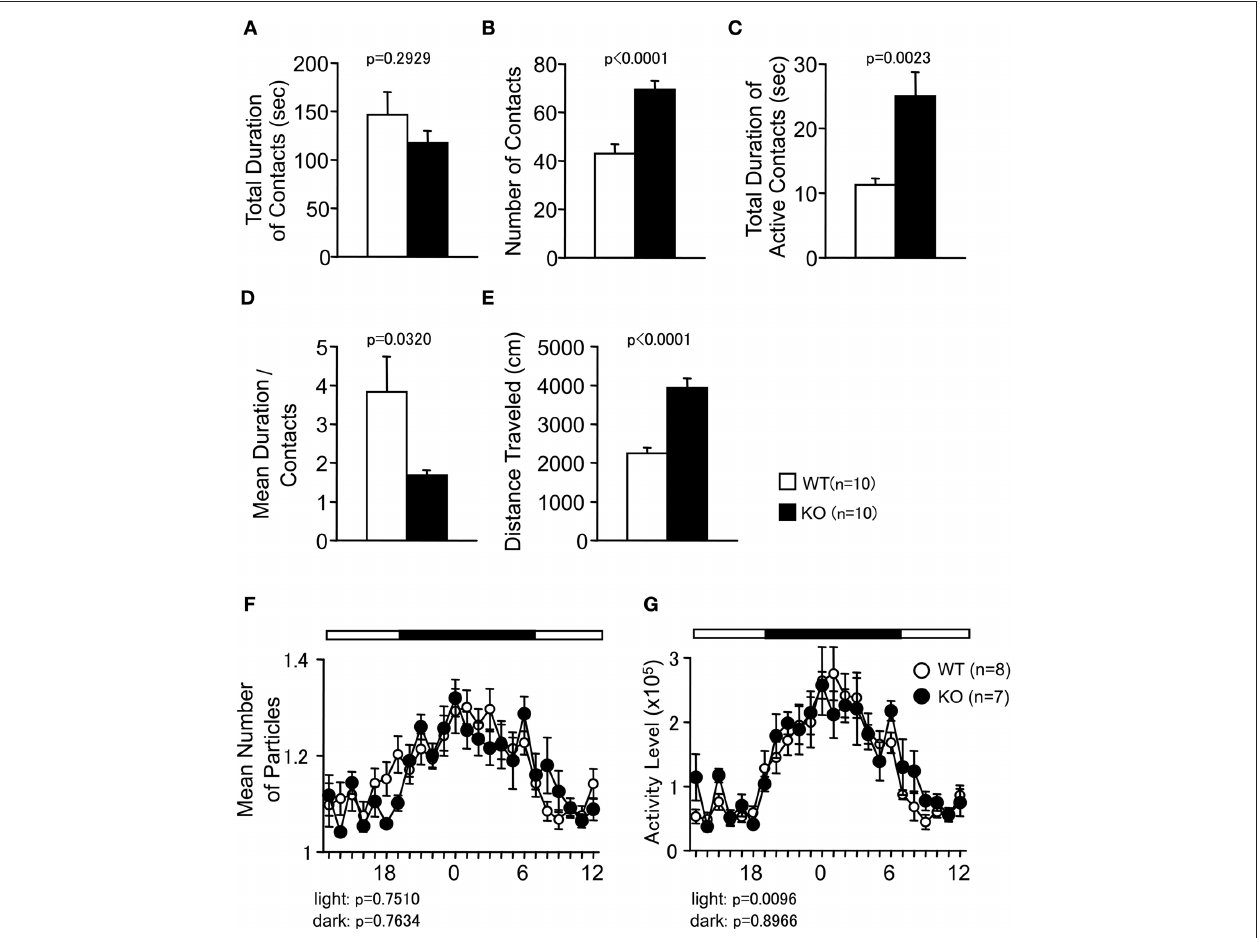
FIGURE 4 | Social behaviors of PACAP KO mice in a novel environment and home cage. (A–E) Social interaction in a novel environment: the total duration of contacts (A) , number of contacts (B) , total duration of active contacts (C) , mean duration of each contact (D) , and total distance traveled (E) were shown. (F,G) Social interaction in